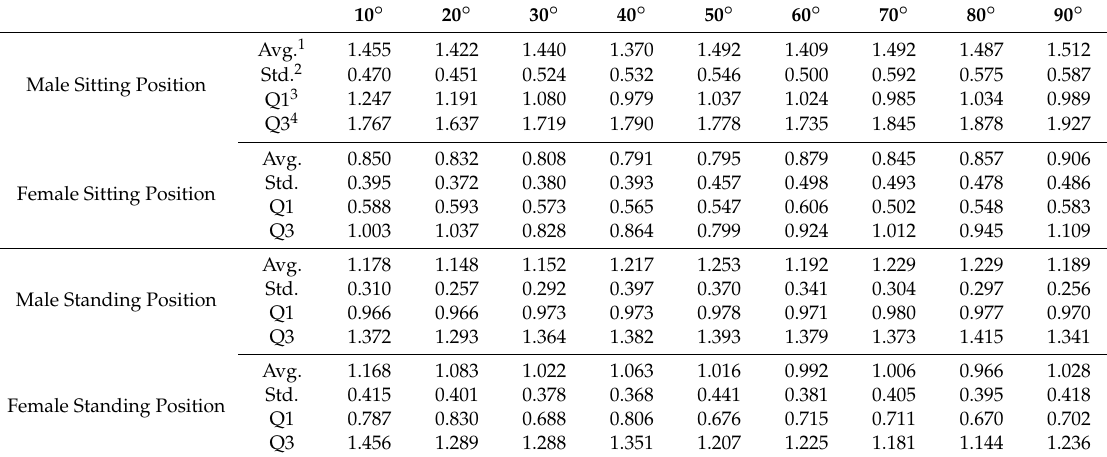
Table 2. Summary of observations for the ratio of internal/external muscle strength between male and female subjects in a sitting and standing position with 10 ◦ –90 ◦ kick training. 10 ◦ 20